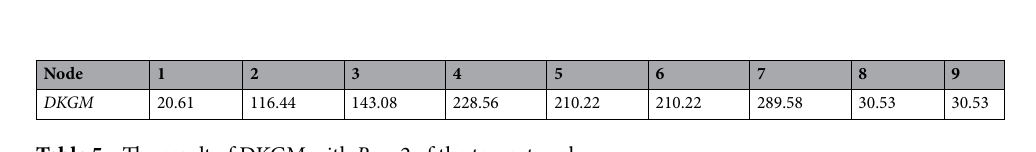
Table 5. The result of DKGM with R = 2 of the toy network.